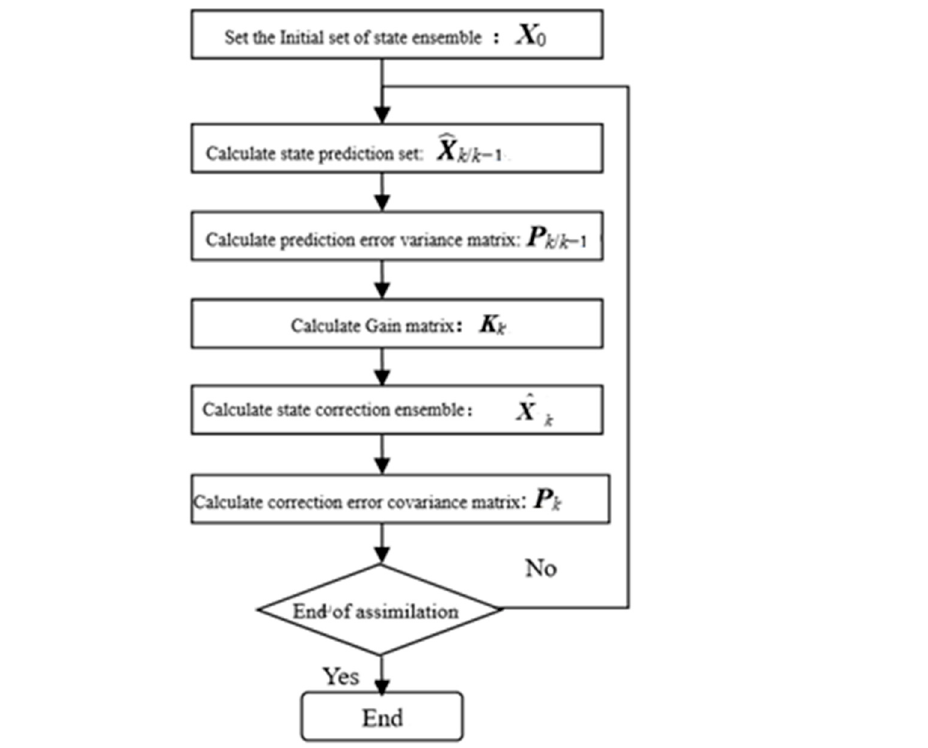
Figure 1. Flowchart of the EnKF-based data assimilation process.